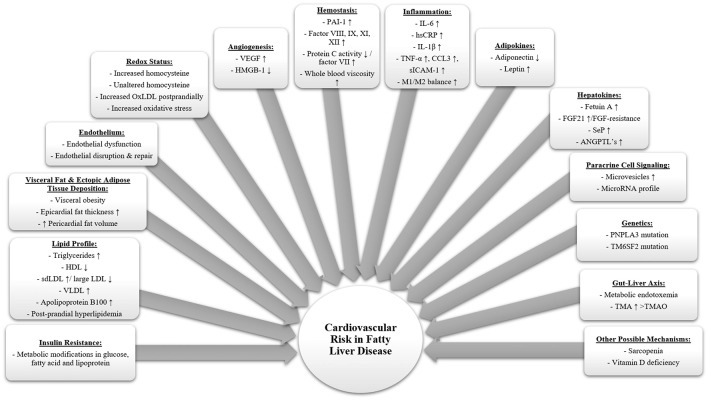
Summary of potential pathophysiological mechanisms associating fatty liver disease with an increased cardiovascular risk. Fatty liver disease leads to multiple alterations in the human body as summarized in this figure, ultimately causing several complications including cardiovascular disease. Low grade systemic inflammation plays an essential role in the development of fatty liver disease. It can be explained by several intertwined factors such as diet, gut, microbiota, genes, visceral adipose tissue and liver. (ANGPTL, Angiopoietin like proteins; FGF21, Fibroblast growth factor 21; HDL, High-density lipoproteins; HMGB-1, High mobility group box 1; hsCRP, High sensitivity C-reactive protein; IL-1b, Interleukin 1b; IL-6, Interleukin 6; LDL, Low density lipoprotein; M1/M2, Macrophage phenotype 1/2 ratio; OxLDL, Oxidized low-density lipoprotein; PAI-1, Plasminogen activator inhibitor 1; PNPLA3, Patatin-like phospholipase domain containing protein 3; sdLDL, Small dense low-density lipoproteins; SeP, Selenoprotein P; sICAM-1, Soluble intercellular adhesion molecule-1; TM6SF2, Transmembrane 6 superfamily member 2; TMA, Trimethylamine; TMAO, Trimethylamine-N-Oxide; TNFα, Tumor necrosis factor a; VEGF, Vascular endothelial growth factor; VLDL, Very low-density lipoprotein).